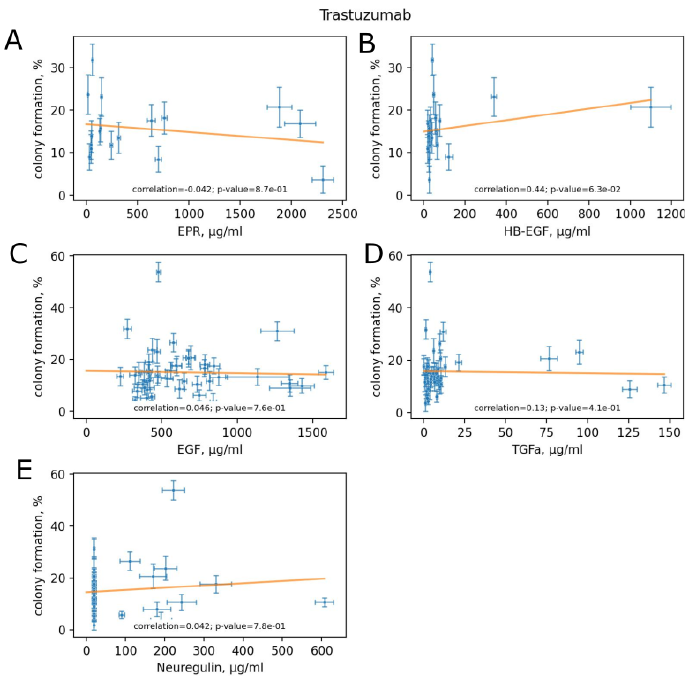
Figure 6. Concentrations of HER ligands in serum vs. clonogenicity with trastuzumab: ( A ) epiregulin; ( B ) HB-EGF; ( C ) EGF; ( D ) TGFa; ( E ) neuregulin. The data are presented as mean ± standard deviation from three independent replicates.